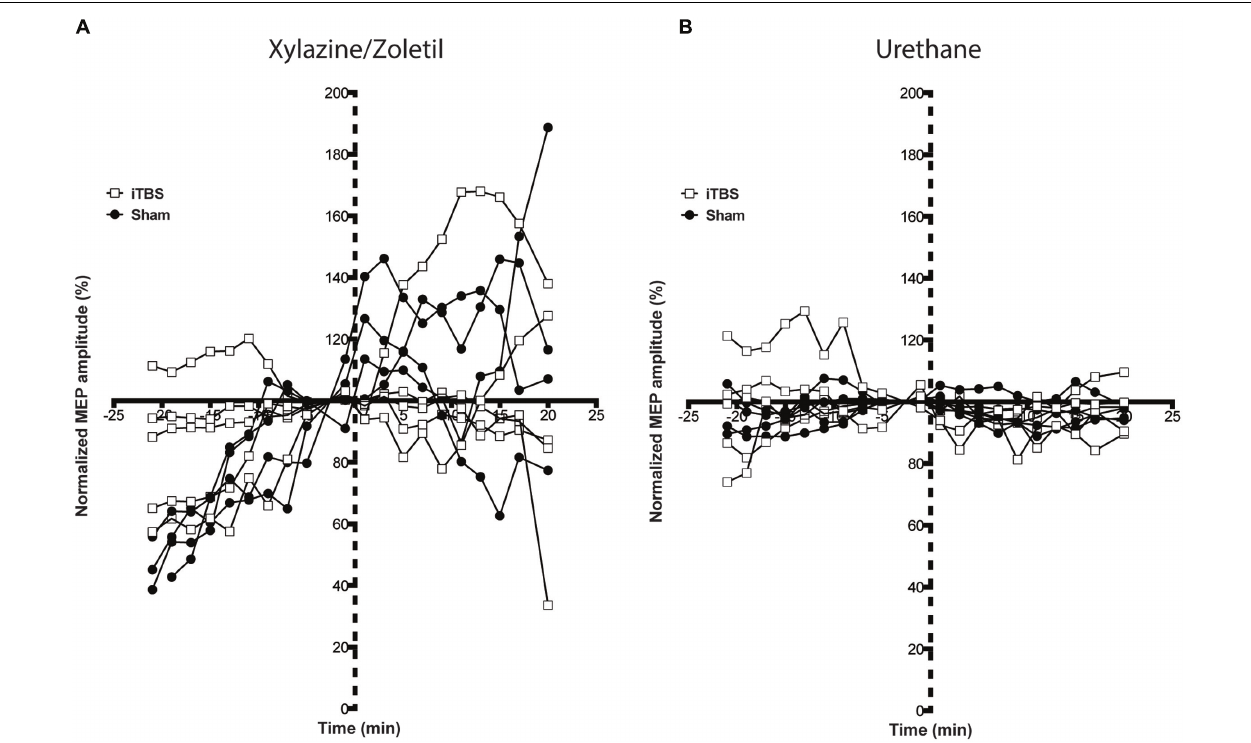
FIGURE 4 | Motor evoked potentials recorded from individual animals under each anesthetic, with both iTBS and sham animals shown together. Variability between animals anesthetized with (A) xylazine/zoletil is greater than in animals anesthetized with (B) urethane. A rising amplitude over the baseline recording period can be seen in most animals in (A) . Two rats show a moderate rising amplitude whereas a single rat shows a falling baseline. Stimulated animals are shown with squares; sham animals with filled circles. Dashed axis line indicates Sham or iTBS treatment (time point 0).